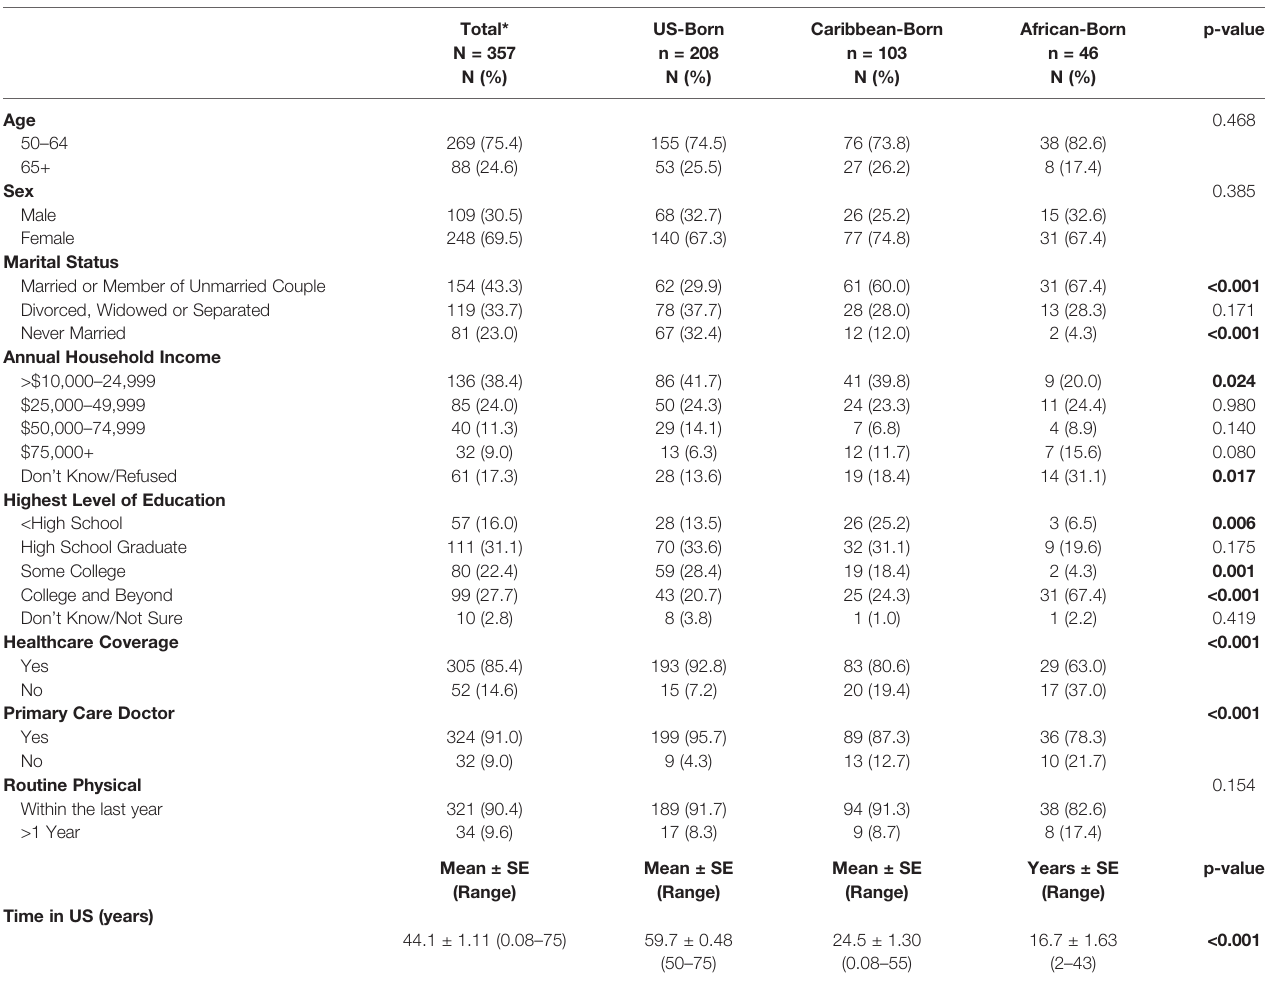
TABLE 1 | Respondent characteristics (N =